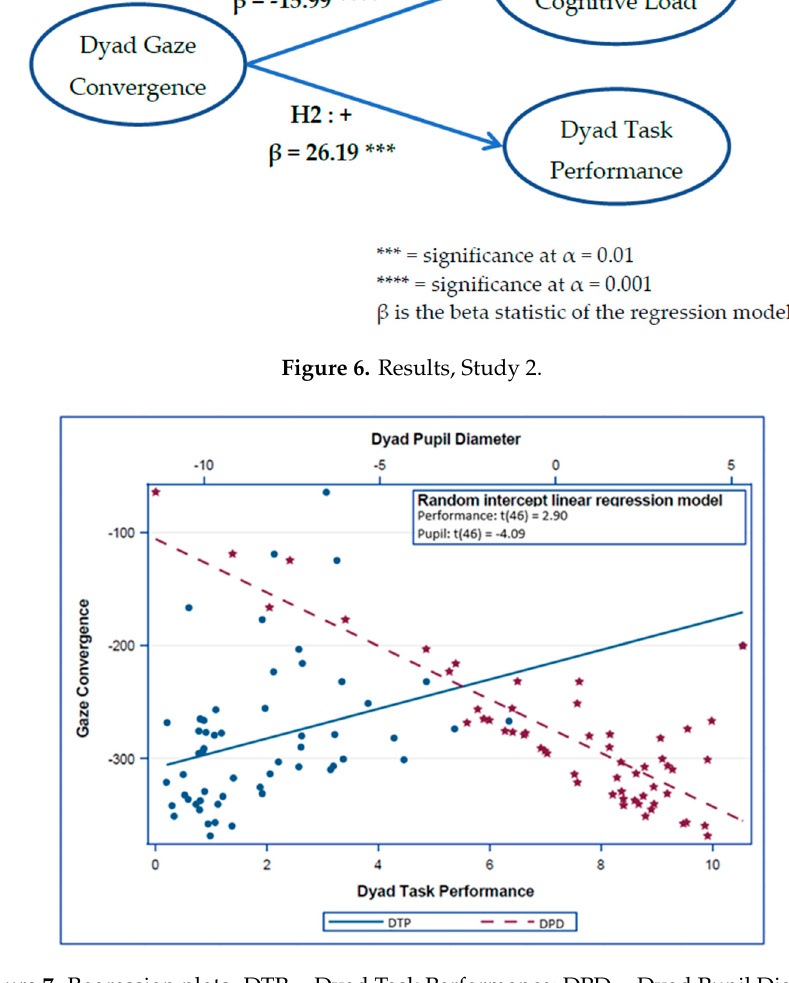
Figure 7. Regression plots. DTP = Dyad Task Performance; DPD = Dyad Pupil Diameter.